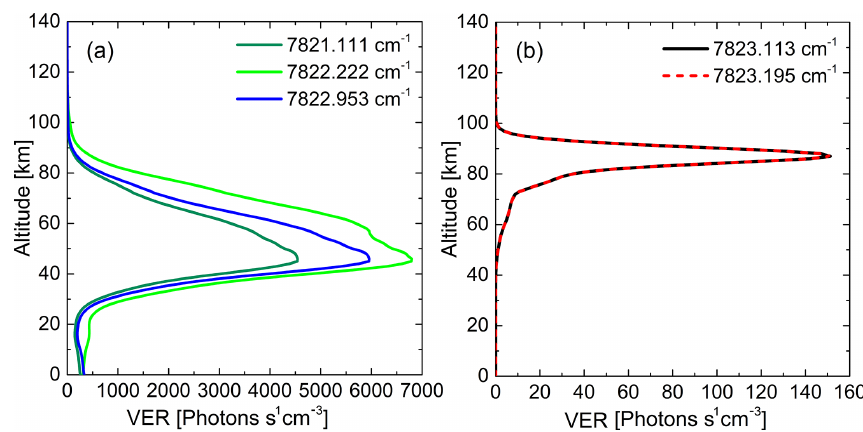
Figure 1. The VER profiles of both the three weak target emission lines of the 1.27µm O 2 dayglow and the two emission lines of OH.